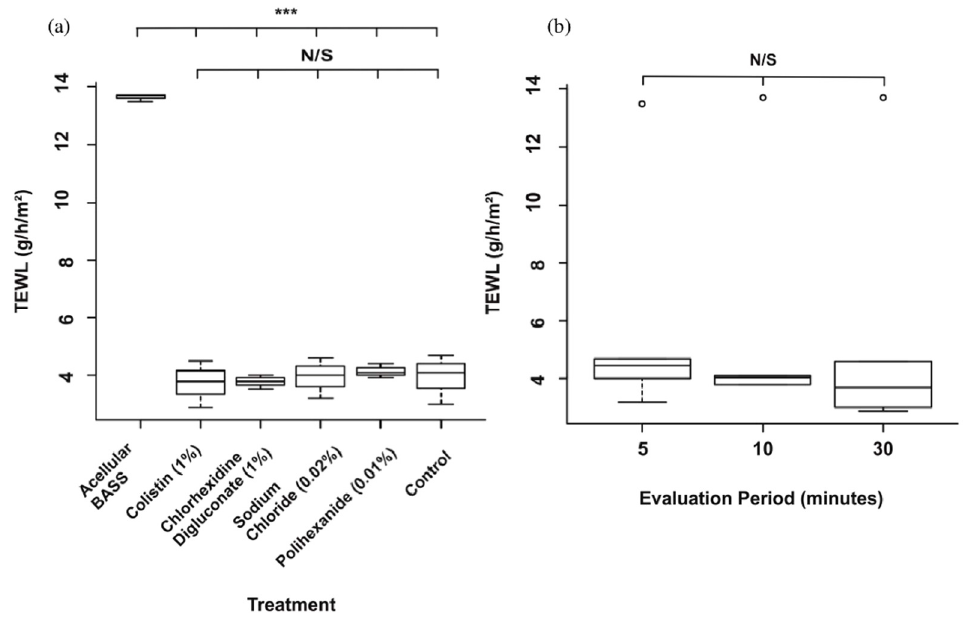
Figure 9. Statistical analysis of TEWL measurement. ( a ) Boxplot of BASS TEWL values regarding the treatment used. ( b ) Boxplot of BASS TEWL values regarding the evaluation period. *** p ≤ 0.001, N/S: no significant differences .